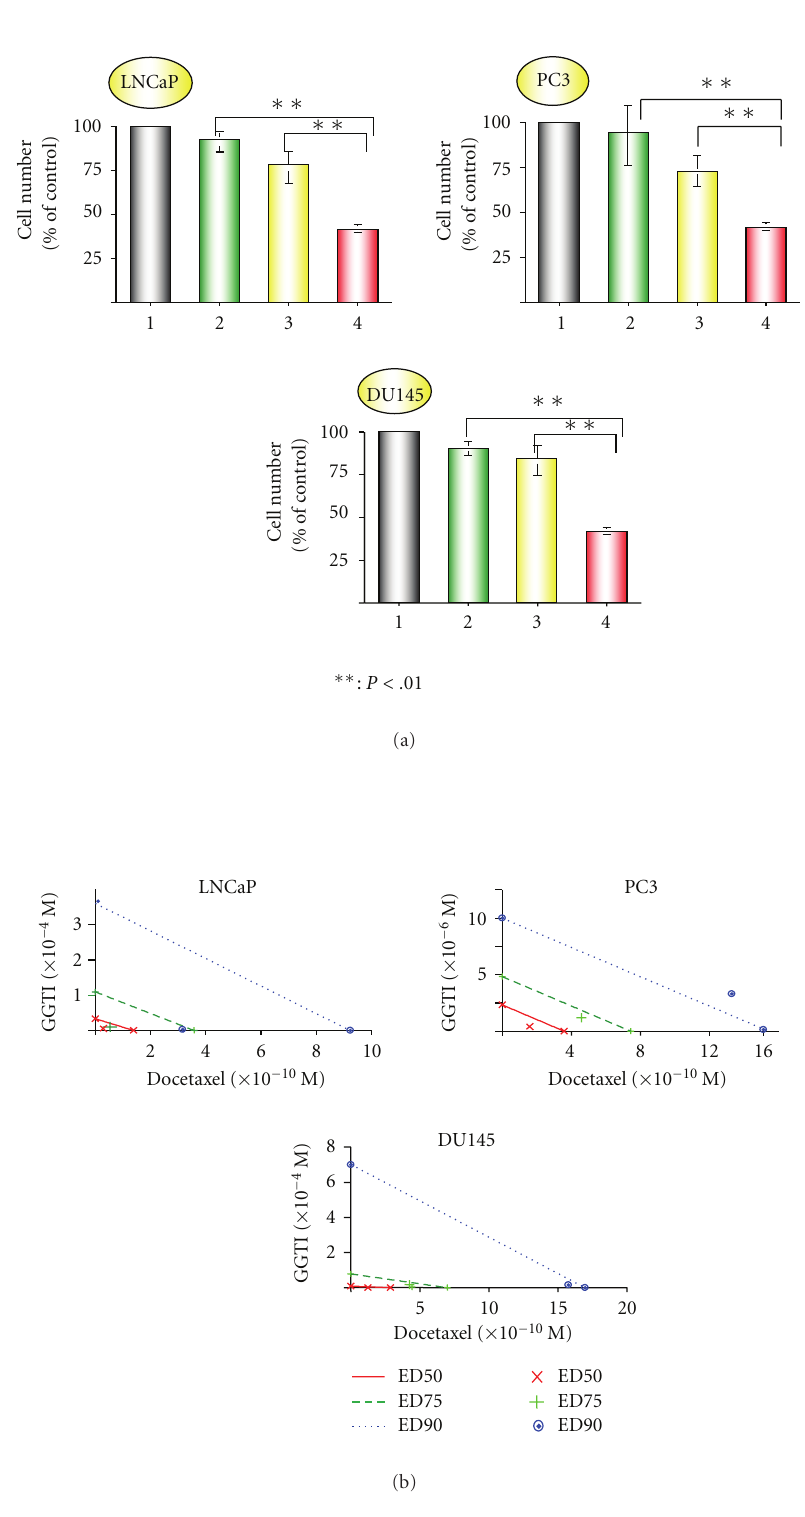
Figure 4: Combined e ff ect of GGT and docetaxel. (a) Cells were exposed to GGTI (1 μ M) in combination with docetaxel (10 − 10 M). Following 72h incubation, the cell growth was determined. Lane 1: control, lane 2: GGTI, lane 3: docetaxel, and lane 4: GGTI and docetaxel. (b) Cells were incubated in the serial concentrations of GGTI, docetaxel, or combination of those agents for 72h. Cell growth was determined, and combination e ff ect was analyzed by isobologram. The individual doses of GGTI and docetaxel to achieve 90% (dotted line) growth inhibition (Fa = 0.90), 75% (hyphenated line) growth inhibition (Fa = 0.75), and 50% (straight line) growth inhibition (Fa = 0.50) were plotted on the x - and y -axes. Combination index values are represented by points above (indicate antagonism between drugs) or below the lines (indicate synergy). (X symbol) ED 50 , (plus sign) ED 75 , and (closed circle) ED 90